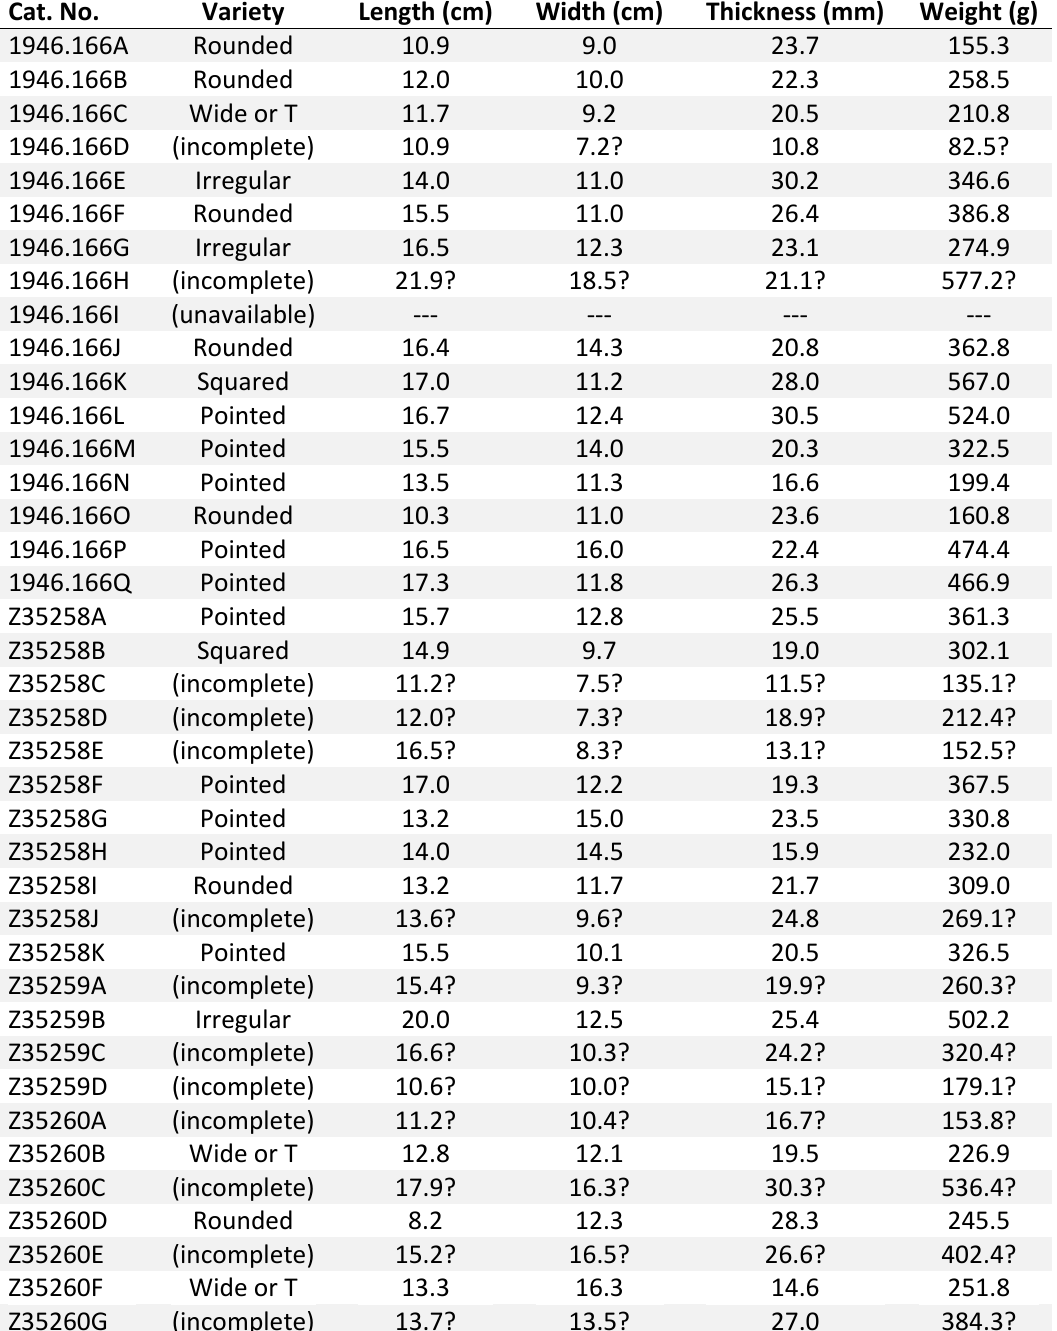
Table 2: Individual axe specimens and dimensions from the Moyne-Feachem collection (Cambridge University Museum of Archaeology and Anthropology). Measurements followed by a “?” represent incomplete dimensions. Cat.